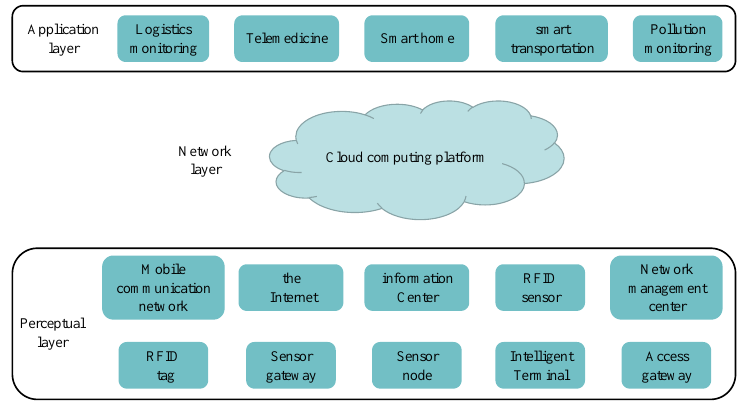
Figure 1. the Architecture diagram of smart campus. Figure 1. The Architecture diagram of smart